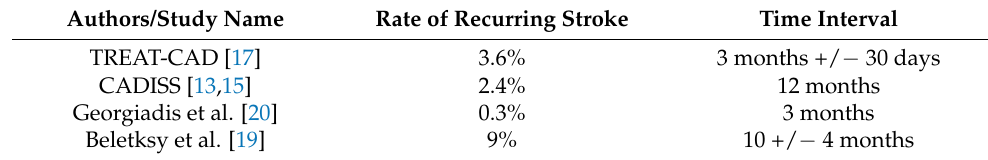
Table 2. Rate of recurrent stroke in preceding